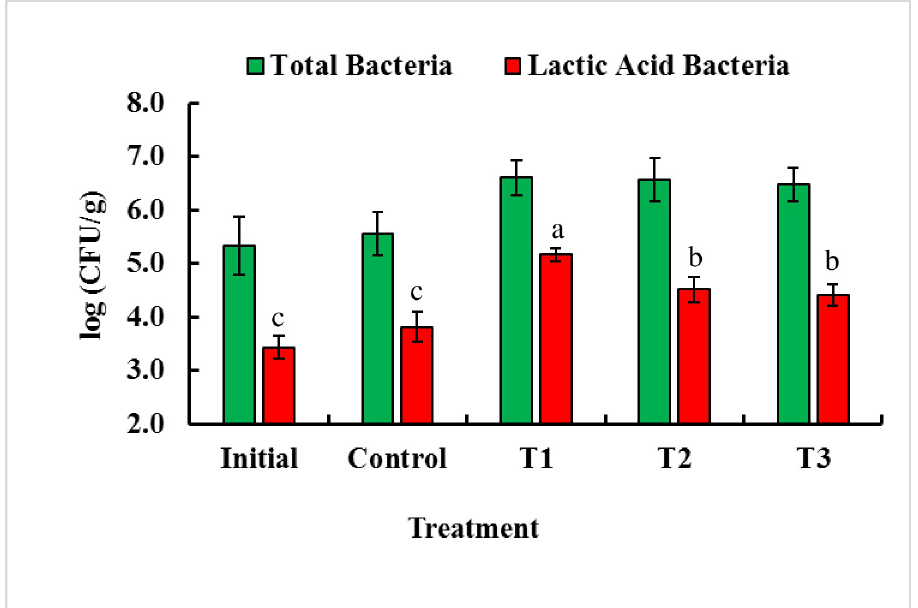
Fig 2. Assessment of the effects of dietary chitosan on the culturable autochthonous bacteria and autochthonous lactic acid bacteria levels (log CFU/g intestine) of B . gonionotus . One-way ANOVA was performed to analyze the data of three replicate experiments, and the data in the columns varied significantly according to the least significant difference (LSD) at P < 0.05 (Statistix 10). Different letter bars indicate significant variations in the levels of the culturable autochthonous bacteria and autochthonous lactic acid bacteria of B . gonionotus in different groups at P < 0.05 (Statistix 10). Error bar = ± SD; n = 9.